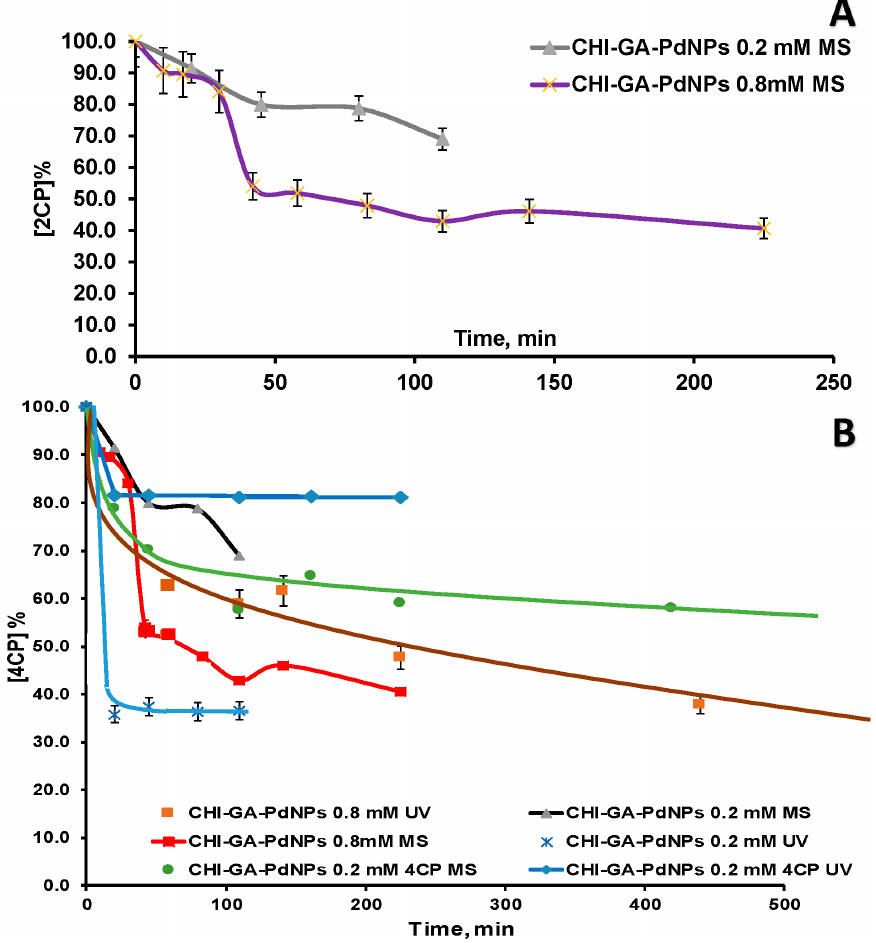
Figure 8. Kinetic curves of chlorophenols (50 ppm) decomposition in a batch mode in presence of CHI-GA-PdNPs 0.2 mM (4.9 µg PdNPs) and 0.8 mM (44.8 µg PdNPs) cryogels and formic acid (20 mM): ( A ) 2CP was monitored by GC-MS; ( B ) 4CP was monitored by GC-MS and UV